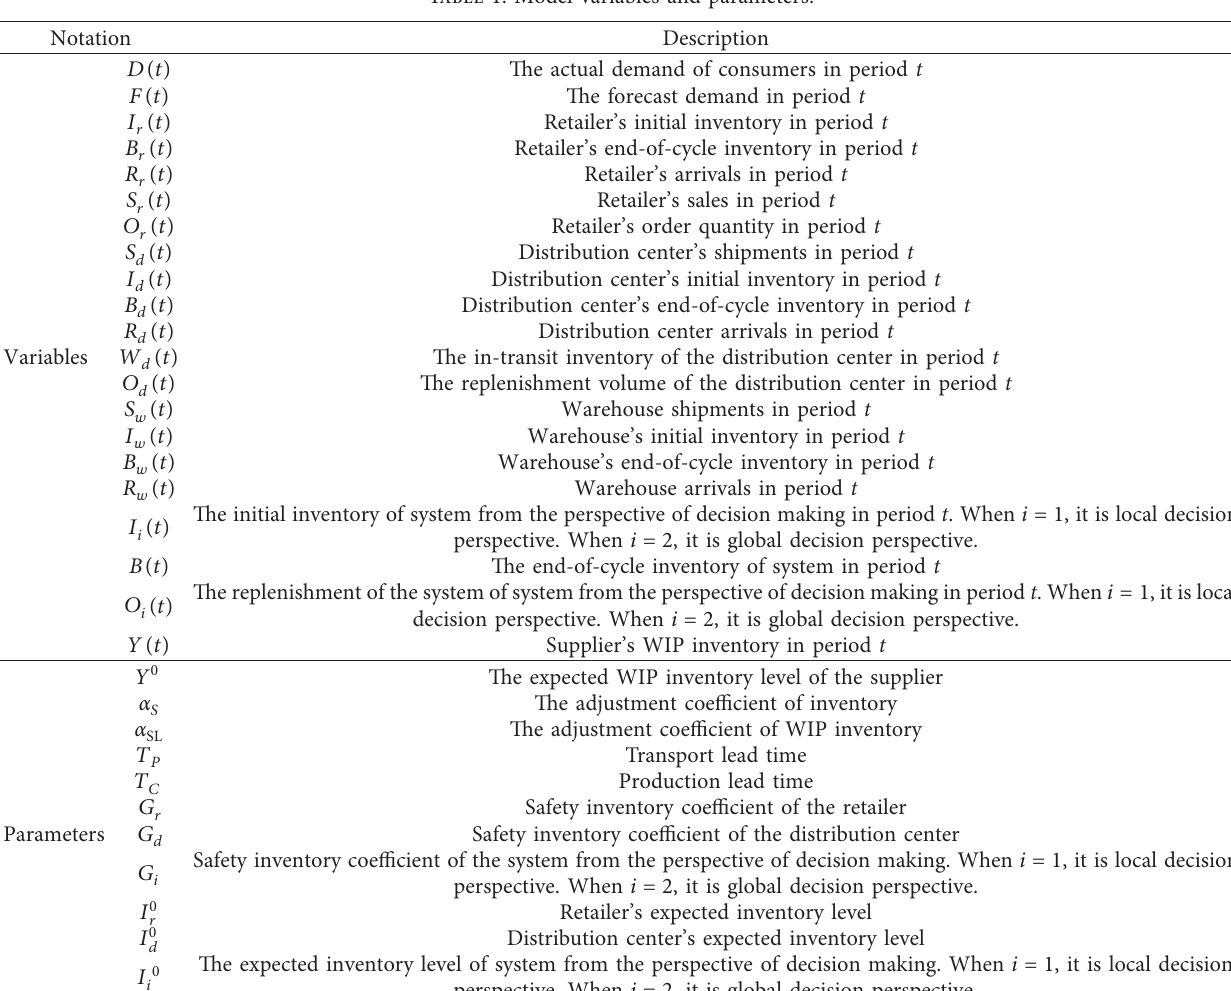
Table 1: Model variables and